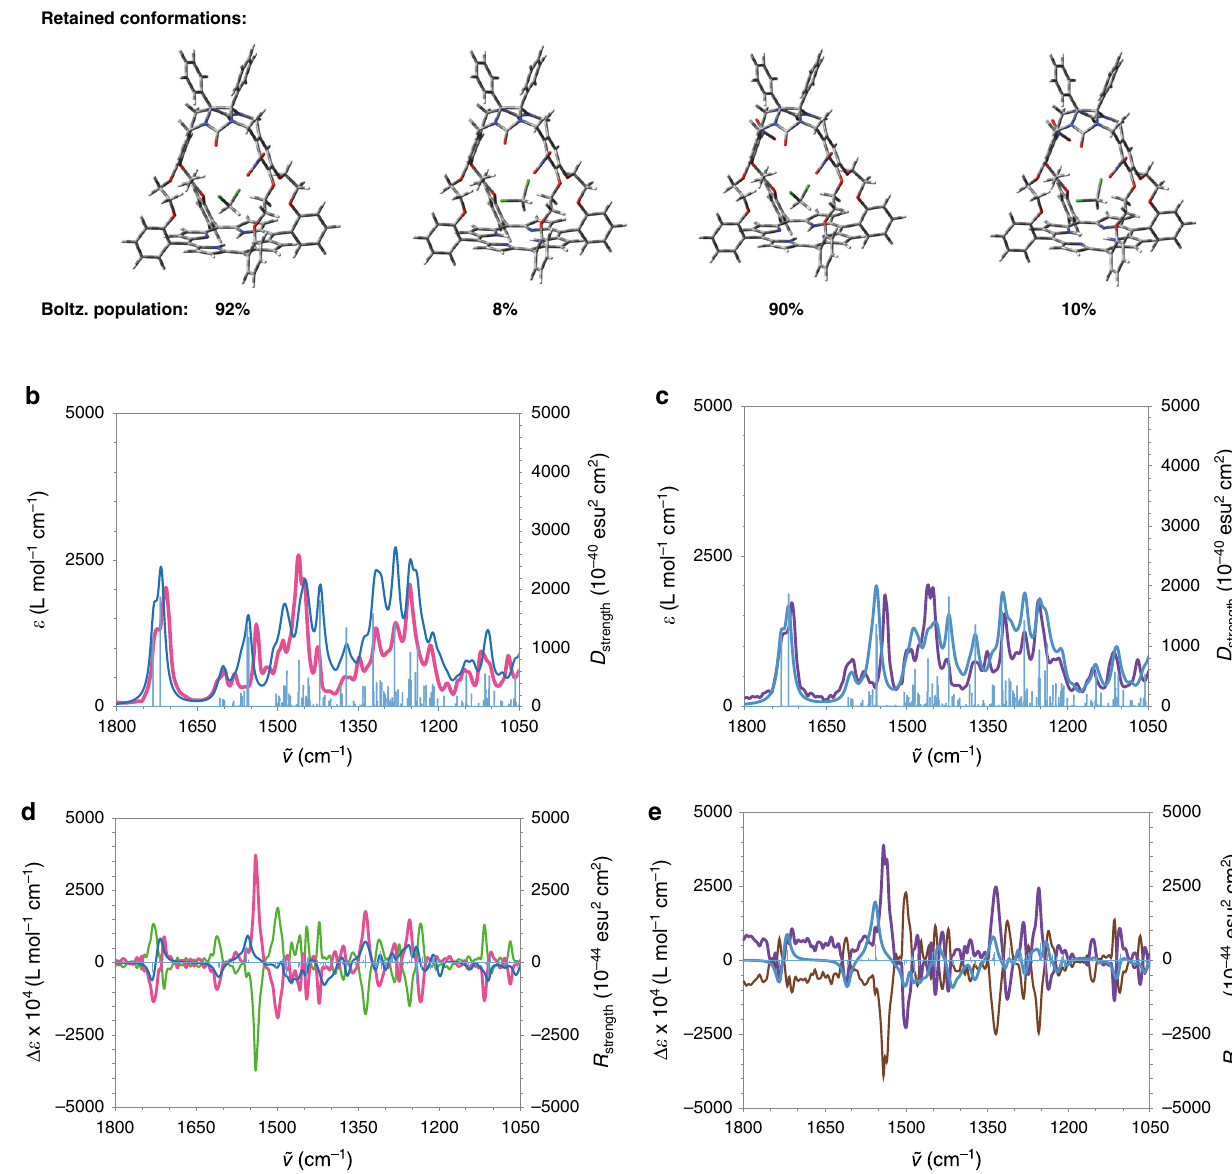
Fig. 2 Experimental and calculated IR and VCD spectra. a Calculated conformations and Boltzmann populations of S p -( R , S )- 1 and S p -( R , R )- 2 . b IR spectra measured for ( + ) − 1 (magenta line) and calculated for S p -( R , S )- 1 (blue line and blue bars: dipole strengths). c IR spectra measured for ( + ) − 2 (purple line) and calculated for S p -( R , R )- 2 (blue and blue bars: dipole strengths). d VCD spectra measured for ( ‒ ) − 1 (green line), ( + ) − 1 (magenta line) and calculated for S p -( R , S )- 1 (blue line and blue bars: rotational strengths). e VCD spectra measured for ( ‒ ) – 2 (brown line), ( + ) − 2 (purple line) and calculated for S p -( R , R )- 2 (blue line and blue bars: rotational strengths). Solvent CD c = 1 × 10 − 1 2 Cl 2 ,